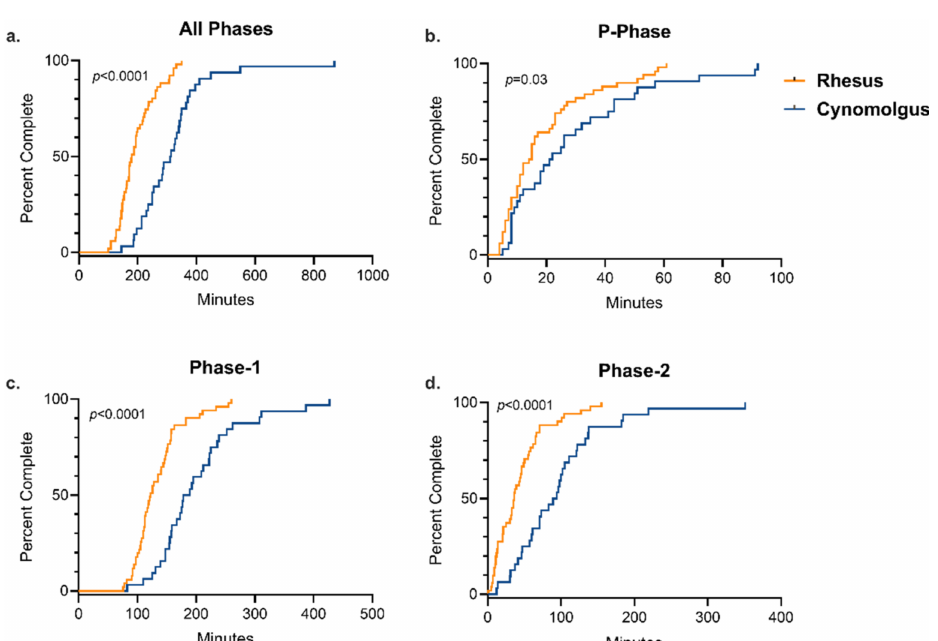
Figure 1. Training Completion Time by Primate Species. Kaplan–Meier time-to-event analysis comparing the time required to successfully complete all phases and individual phases of the training paradigm between rhesus and cynomolgus macaques. There was a significant difference between species for the completion of ( a ) all phases (Log-rank χ 2 = 31.6 (df = 1), p = <0.0001), ( b ) P-Phase (Log-rank χ 2 = 4.2 (df = 1), p = 0.04), ( c ) Phase-1 (Log-rank χ 2 = 22.3 (df = 1), p = <0.0001), and ( d ) Phase-2 (Log-rank χ 2 = 18.7 (df = 1), p =